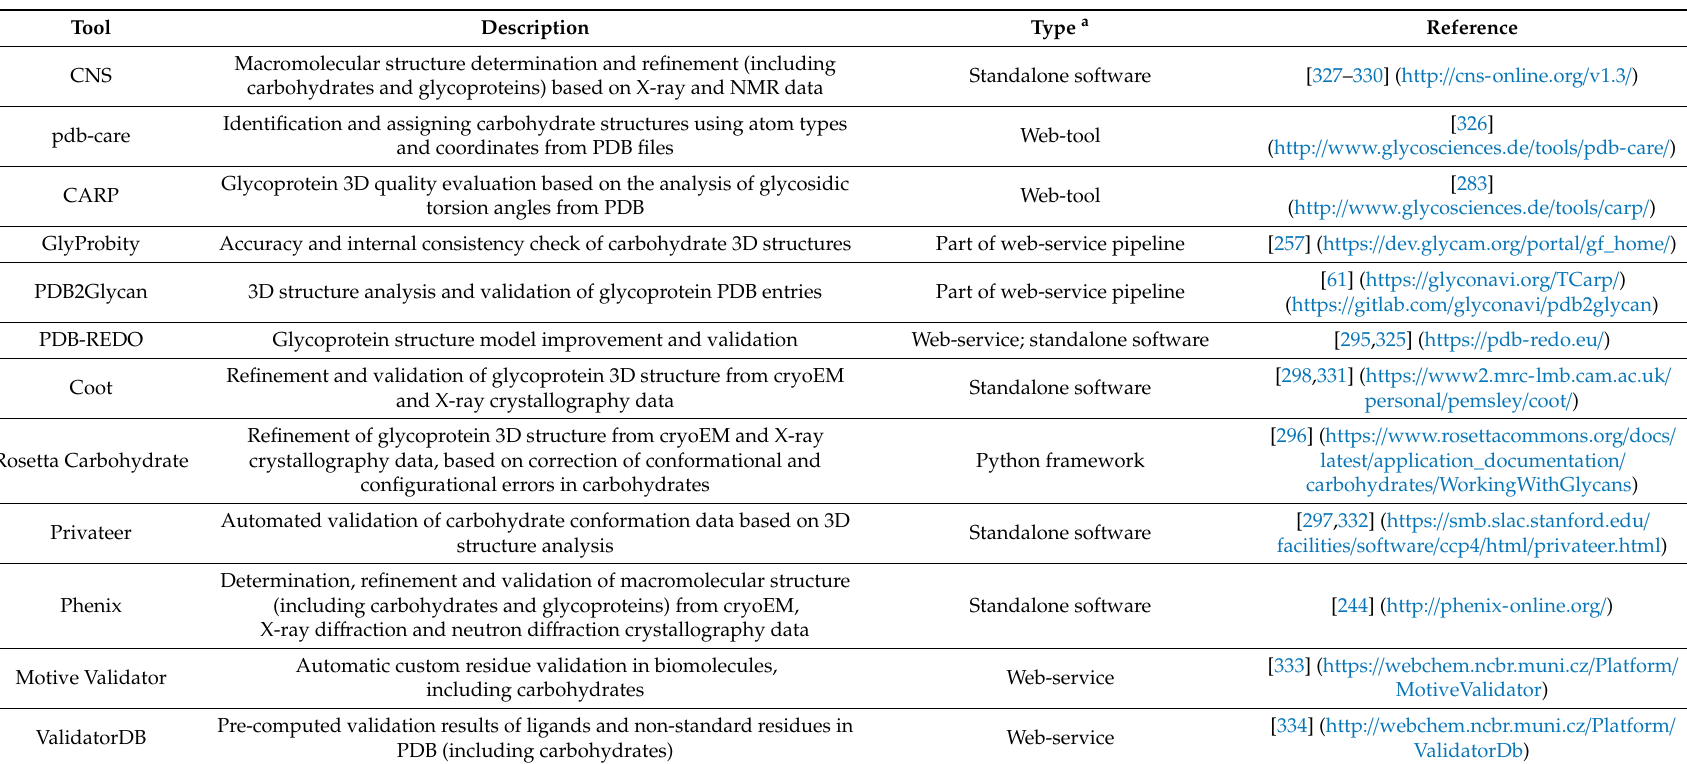
Table 3. Tools for structural validation of